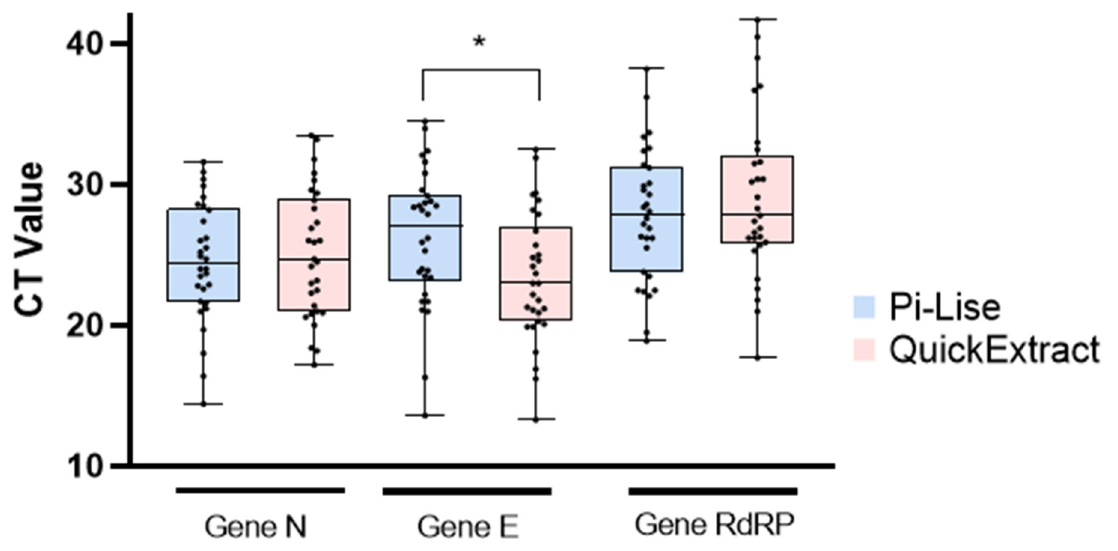
Figure 2. Cycle threshold (CT) values obtained for the genes N, E and RdRp in multiplex RT-qPCR assay after extraction with Pi-Lise and QuickExtract. The graph is presented as individual CT values, the mean and the dispersion (highest and lowest CT values). Statistical analysis was performed for the mean, where * indicates p < 0.05.